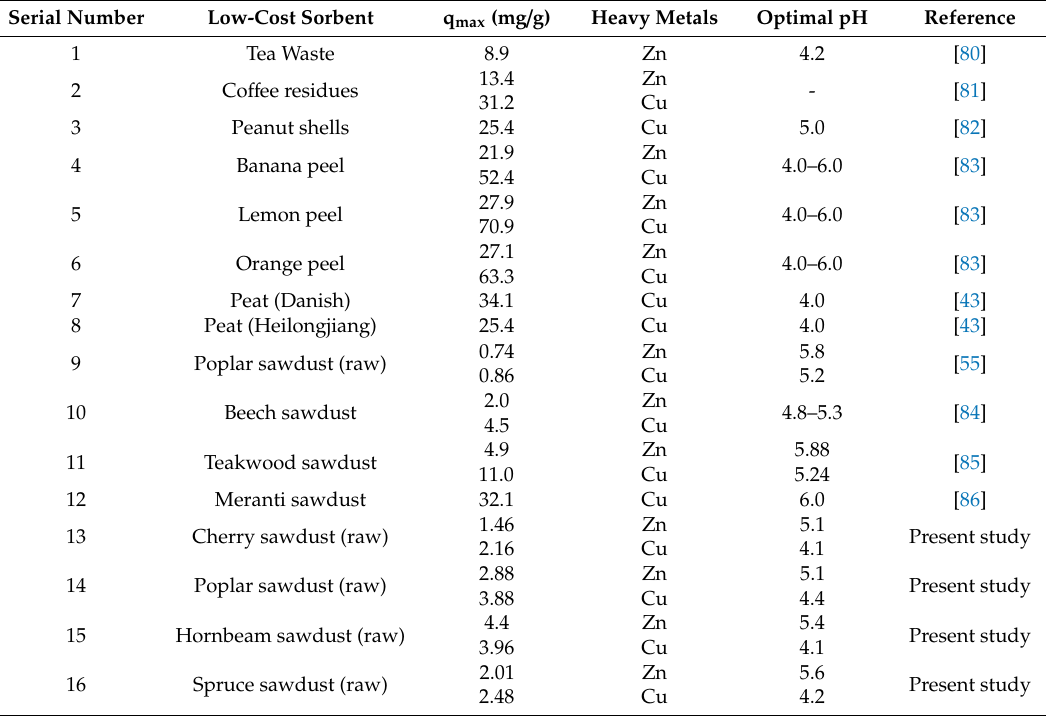
Table 4. The maximum adsorbent capacity ( q max ) of di ff erent low-cost adsorbents.